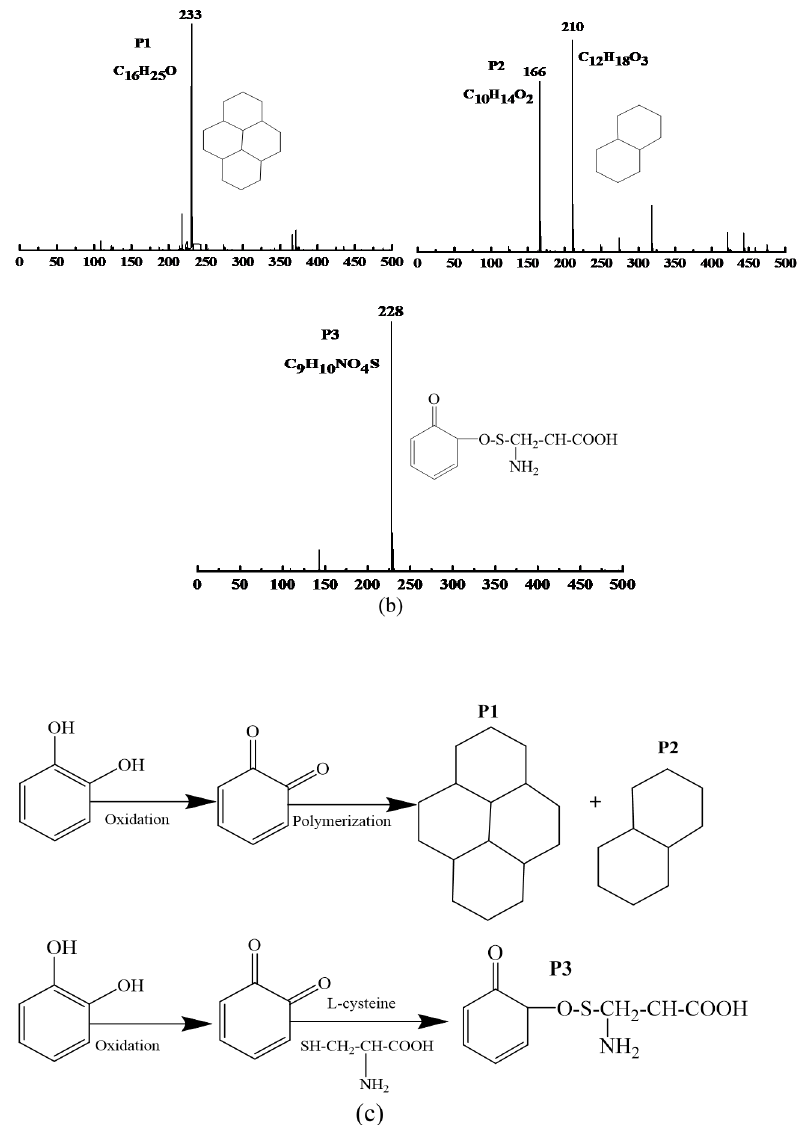
Figure 3. Analysis of enzymatic browning products in PPO-catechol system: ( a ) UPLC spectra in PPO-catechol system, ( b ) mass spectrometry analysis, and ( c ) inhibitory mechanism of L-cysteine on enzymatic browning.